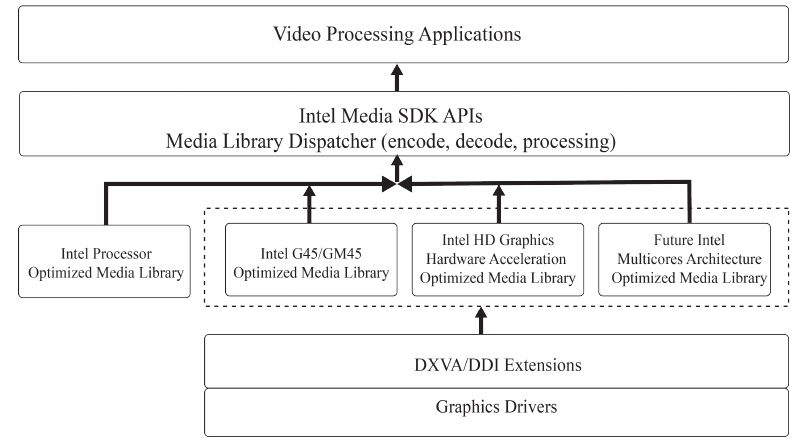
Figure 8. Intel Media SDK architecture.